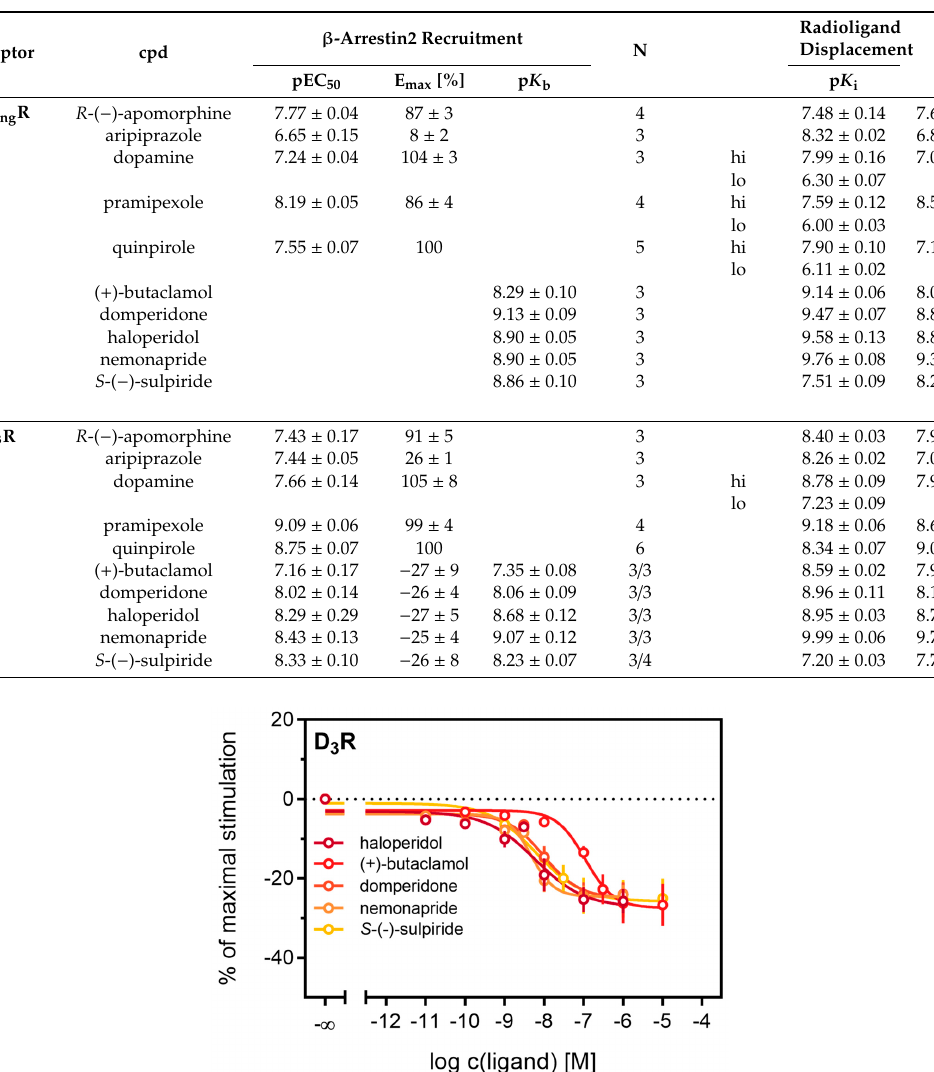
Table 3. pEC 50 , E max and p K b values of standard compounds analyzed in the newly developed β -arrestin2 recruitment assay. For comparison, p K i values determined in radioligand displacement studies utilizing homogenates from HEK293T cells stably expressing the wild-type receptors (cf. Table 2) and published data from di ff erent assays are included. Data represent means ± SEM from N independent experiments, each performed in triplicate.